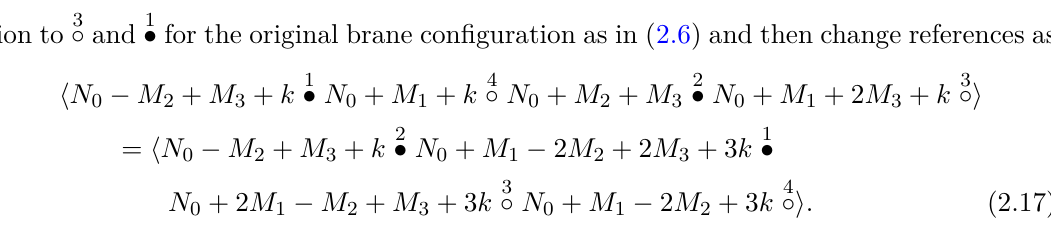
Weyl group. Here we change references into that denoted by · 3 + M + M 0 2 3